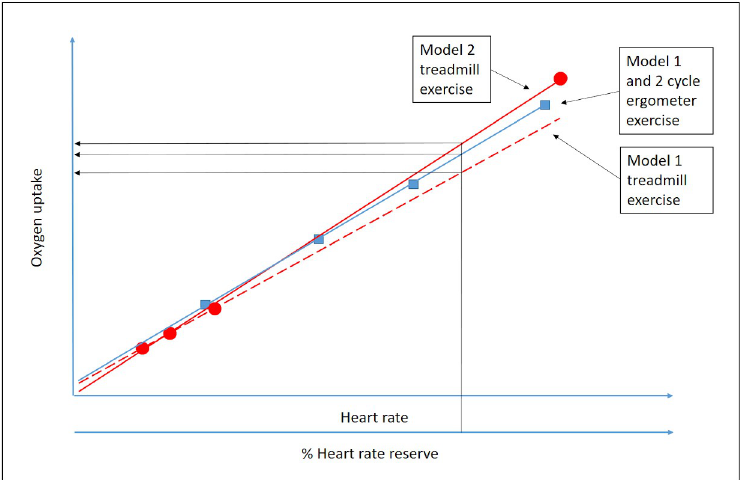
Fig 1. Principal scheme for the analytic models in the study. Two models are used for the HR method to estimate the oxygen uptake in cycle ergometer exercise versus treadmill exercise conditions, respectively. Model 1 is based on three submaximal workloads, whereas model 2 is based on the same three submaximal workloads as well as a workload corresponding to maximal exercise. The figure shows a conceivable example in which model 1 and model 2 in the treadmill exercise results in two different regression equations, whereas in the cycle ergometer exercise, model 1 and model 2 results in the same regression equation. The last step in the HR method is applied here in terms of oxygen uptake being estimated from various percentages of HR reserve and the different regression